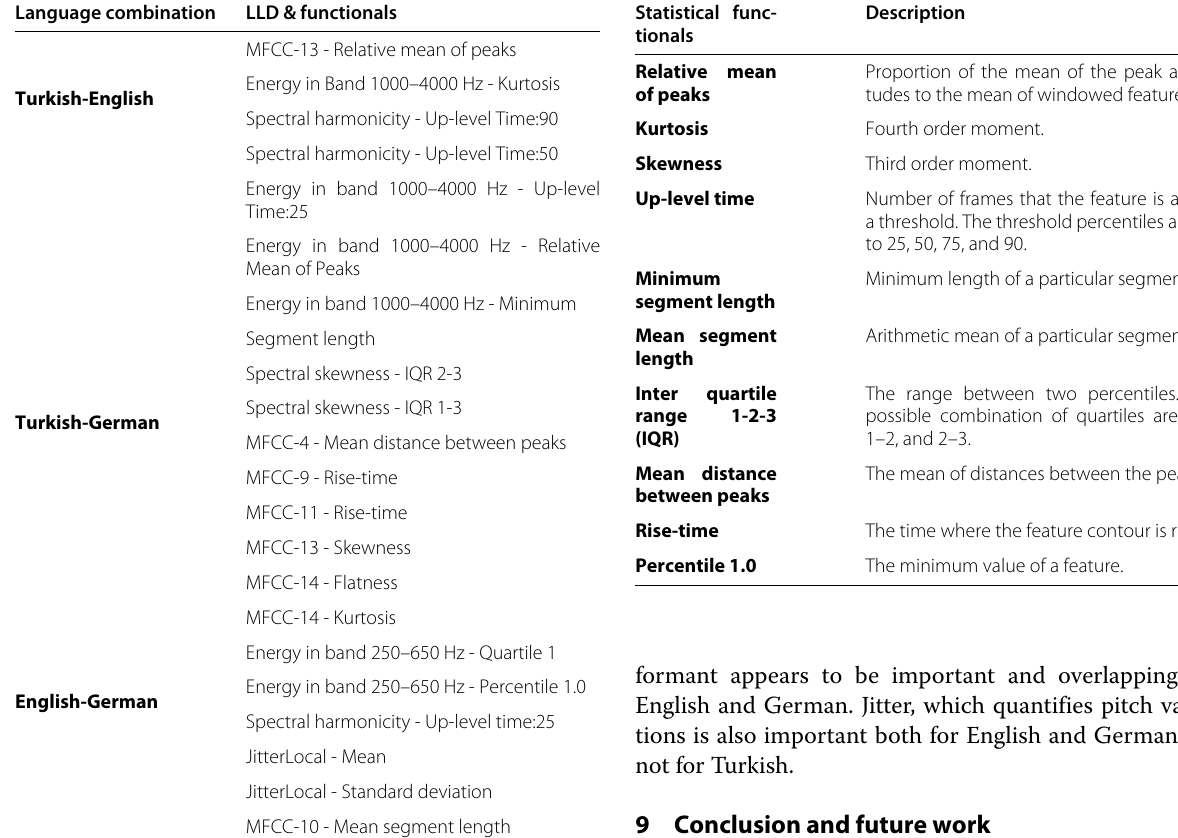
Table 14 Overlapping functionals in language pairs that are in the top 150 MRMR-selected features Statistical func-